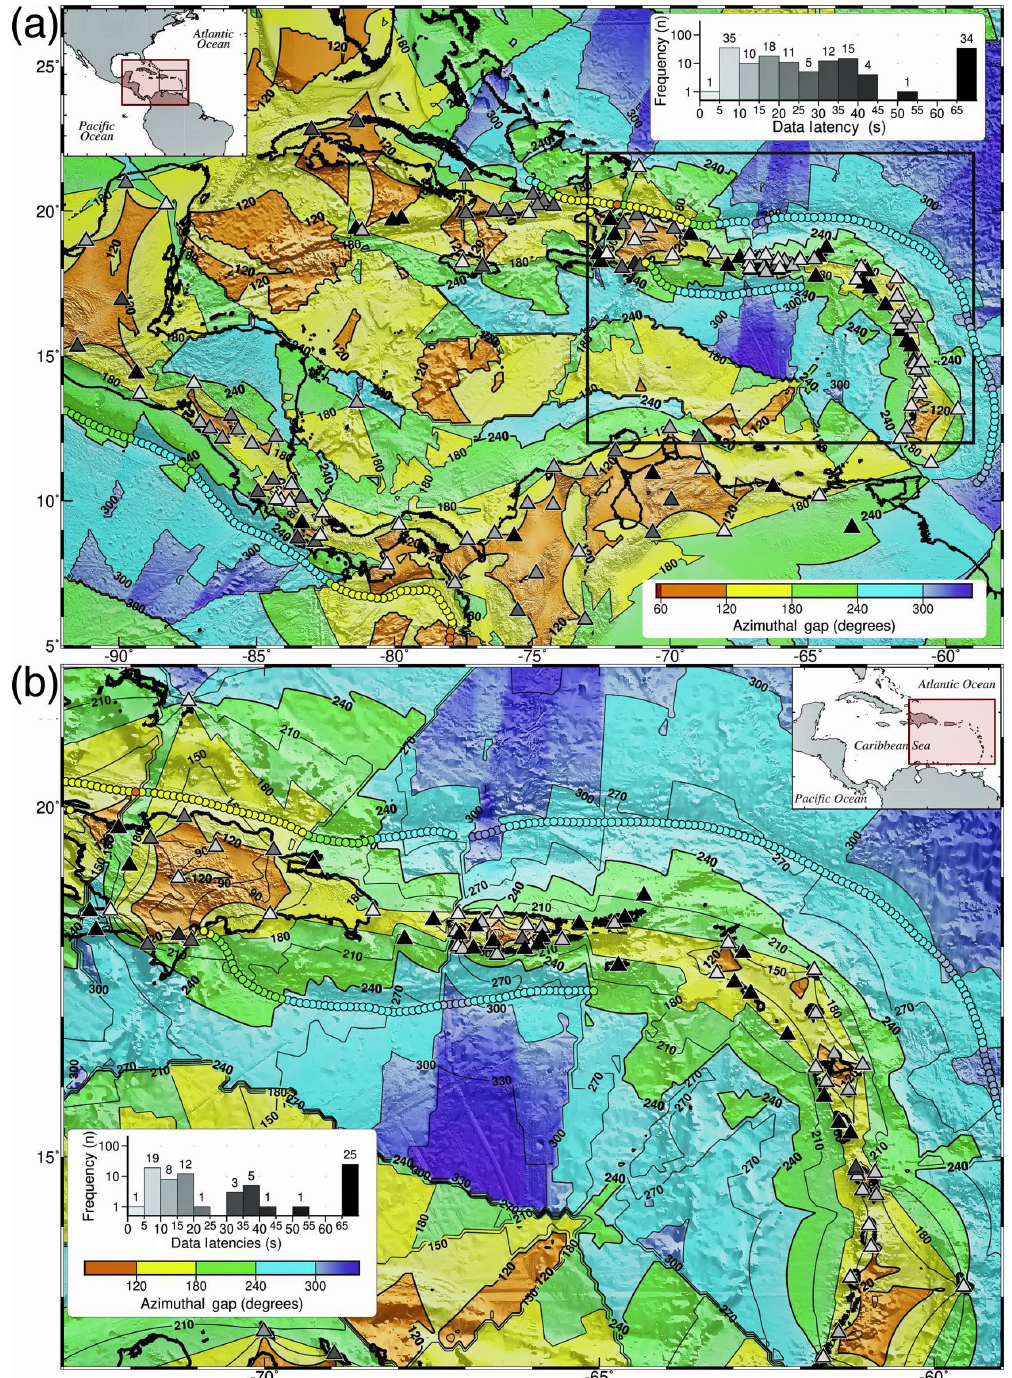
Figure 4. Azimuthal gap in degrees resulting from the detection of the first arriving P wave within the Caribbean at a minimum of eight sta- tions, without azimuth gap restriction, after taking into consideration the median data latencies and station outages within (a) the Caribbean region and (b) within the rectangular area monitored by the PTWC local processing system for the eastern Caribbean. Under normal oper- ational conditions we can expect azimuthal gaps under 180 ◦ (yellow) and 120 ◦ (orange) in just 40.5% and 10.9% of the Caribbean region, respectively. Within the eastern Caribbean area shown in (b) we can expect azimuthal gaps under 180 and 120 ◦ in just 26% and 4.5% of the total area, mostly within smaller sections located along the axis of the most densely instrumented